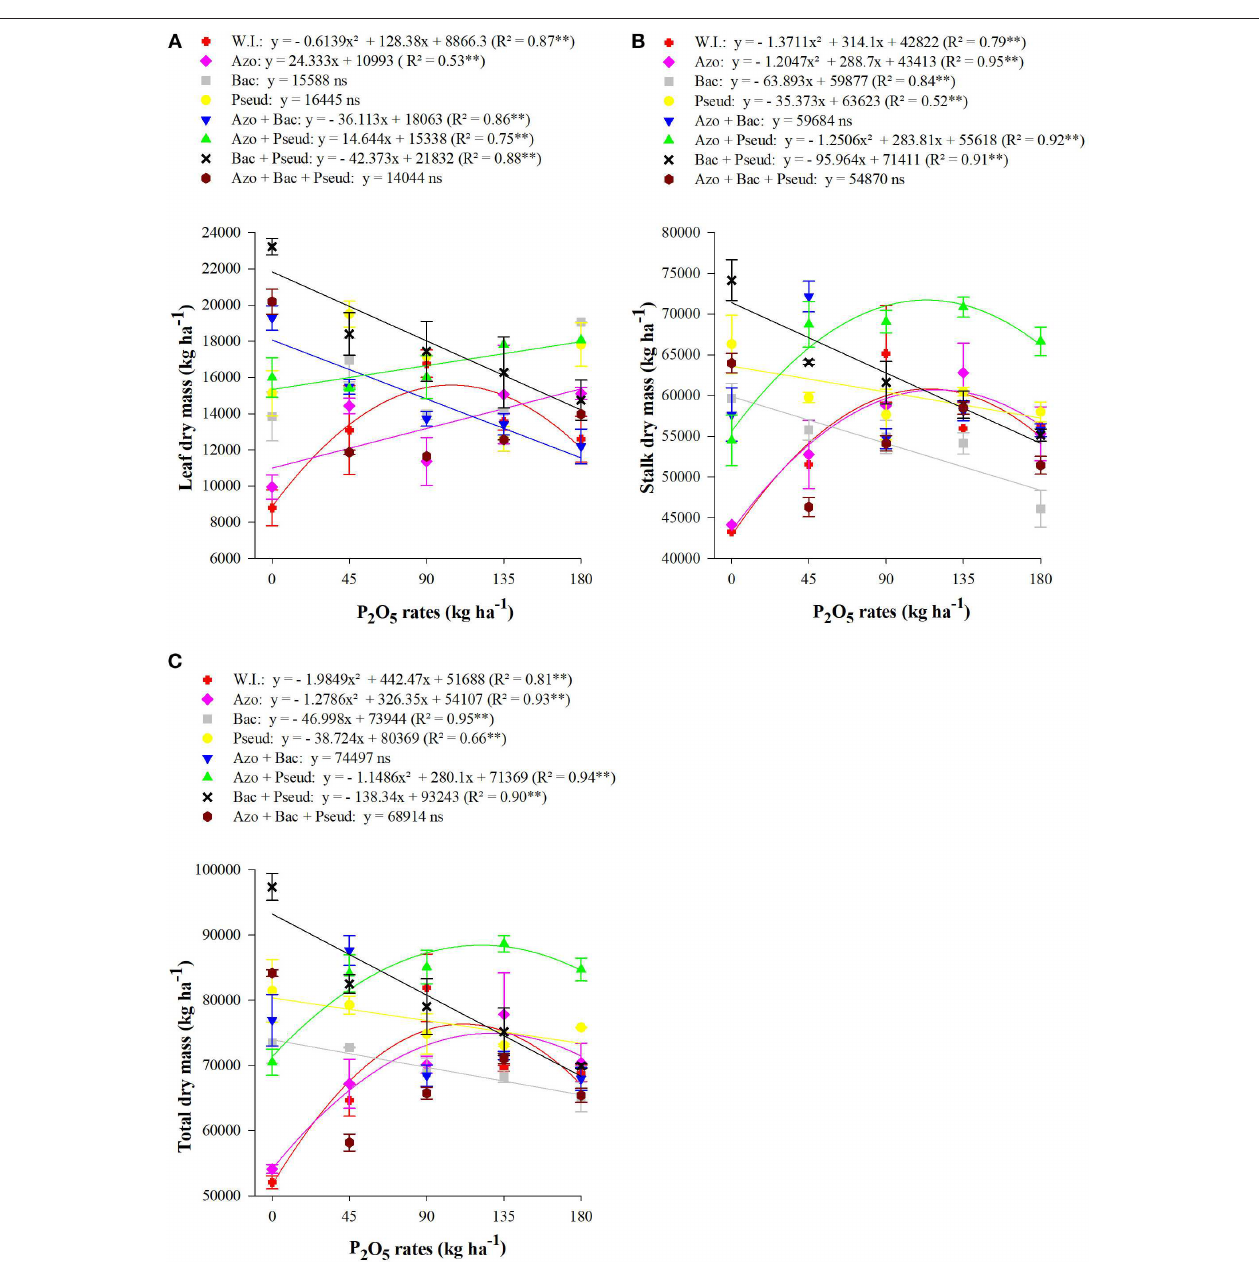
FIGURE 3 | Interactions between different bacterial inoculations and P 2 O 5 doses for leaf dry mass (A) , stalk dry mass (B), and total dry mass (C) at the end of the plant-cane cycle, RB92579 variety (Mean values ± standard deviation). ** and ns: significant at 1% at p < 0.01 and not significant, respectively. W.I., without inoculation; Azo, Azospirillum brasilense ; Bac, Bacillus subtilis ; Pseud, Pseudomonas fluorescens ; Azo + Bac, A. brasilense + B. subtilis ; Azo + Pseud, A. brasilense + P. fluorescens ; Bac + Pseud, B. subtilis + P. fluorescens ; Azo + Bac + Pseud, A. brasilense + B. subtilis + P. fluorescens